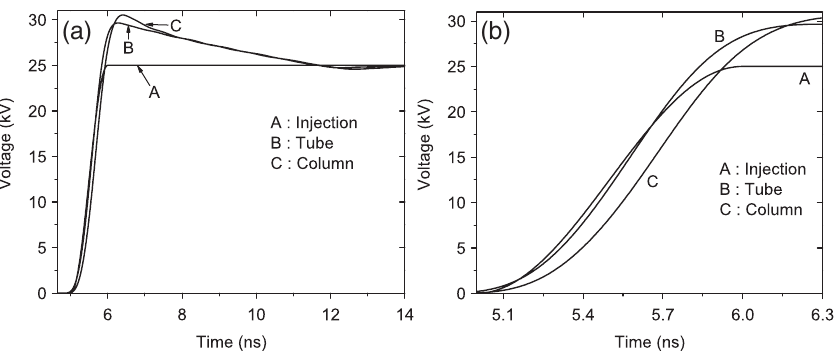
FIG. 10. (a) The response characteristics of the tube water load (B) and the column water load (C) for 1 ns and (b) magnification of (a) during the time from 5 to 6.3 ns.